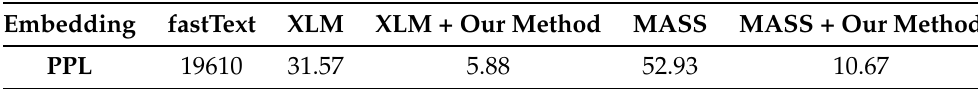
Table 4. The PPL scores of word translation models initialized by different embeddings on each test